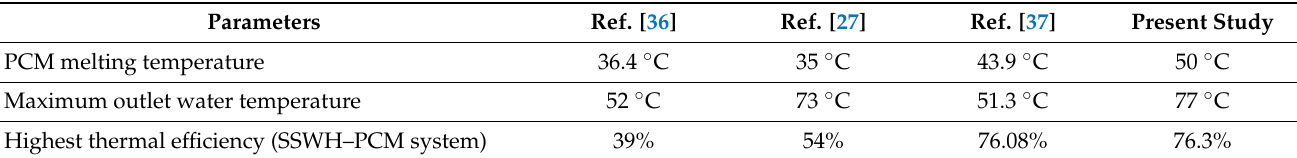
Table 3. Comparison of key performance indicators related to the present SSWH–PCM system and that for the previous